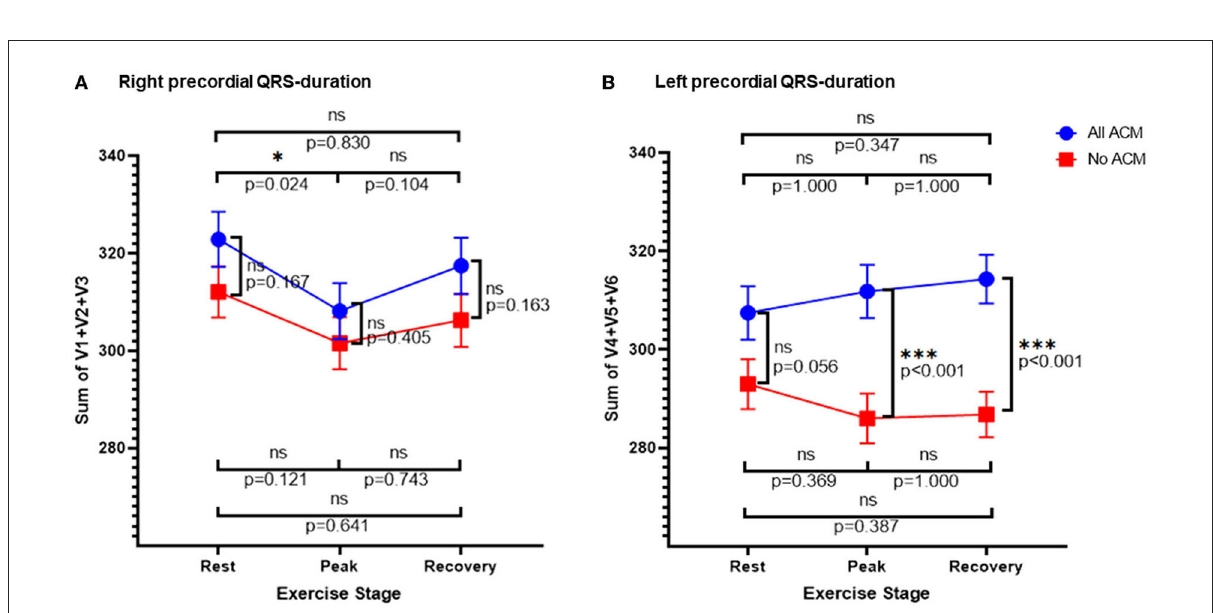
FIGURE3 Right and left precordial QRS duration. Sum of right (A) and left (B) precordial QRS durations over the exercise stages stratified according to the presence or absence of ACM. Error bars represent SE. * p < 0.05, *** p <